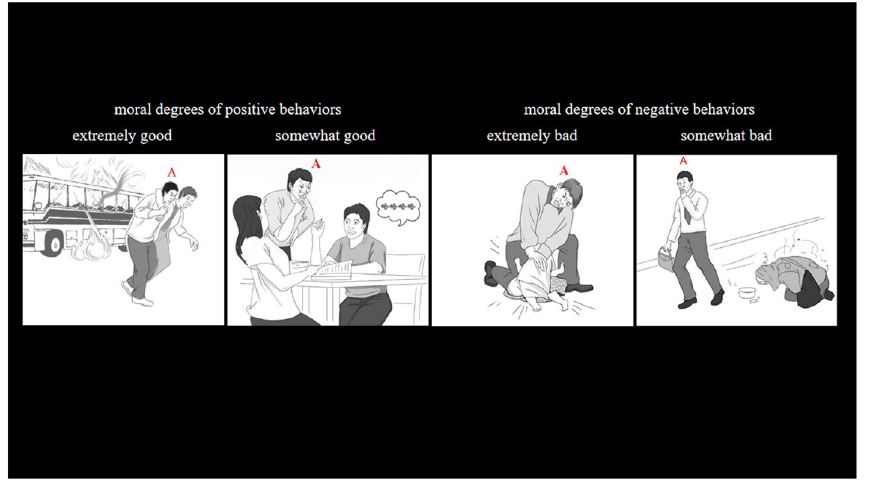
Figure 1. Examples of stimuli in the present experiment. The left two scenarios depict two degrees of morally positive behaviors, in which the male protagonists are performing extremely good and somewhat good behaviors, and the right two scenarios demonstrate two degrees of morally negative behaviors, in which the male protagonists are performing extremely bad and somewhat bad